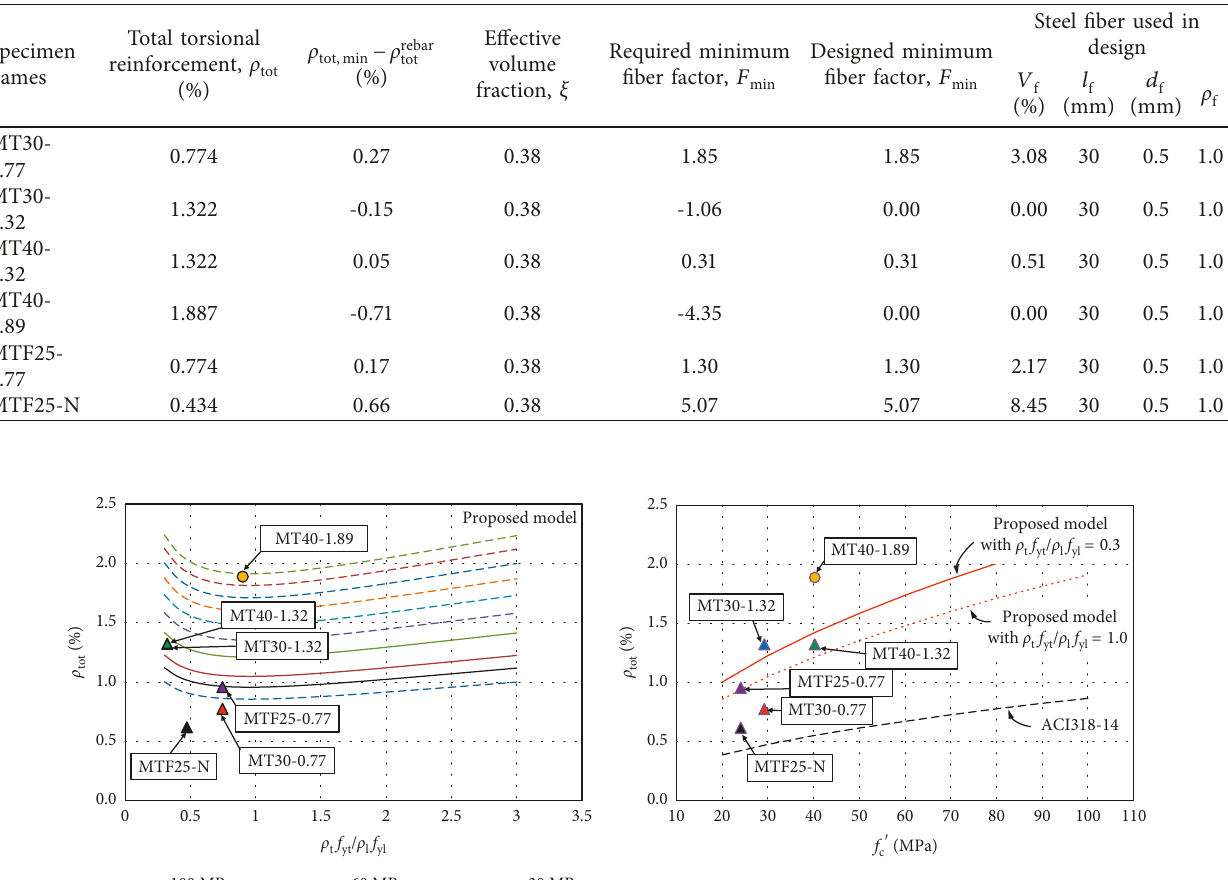
Table 4: Application of the proposed minimum fiber factor to SFRC.